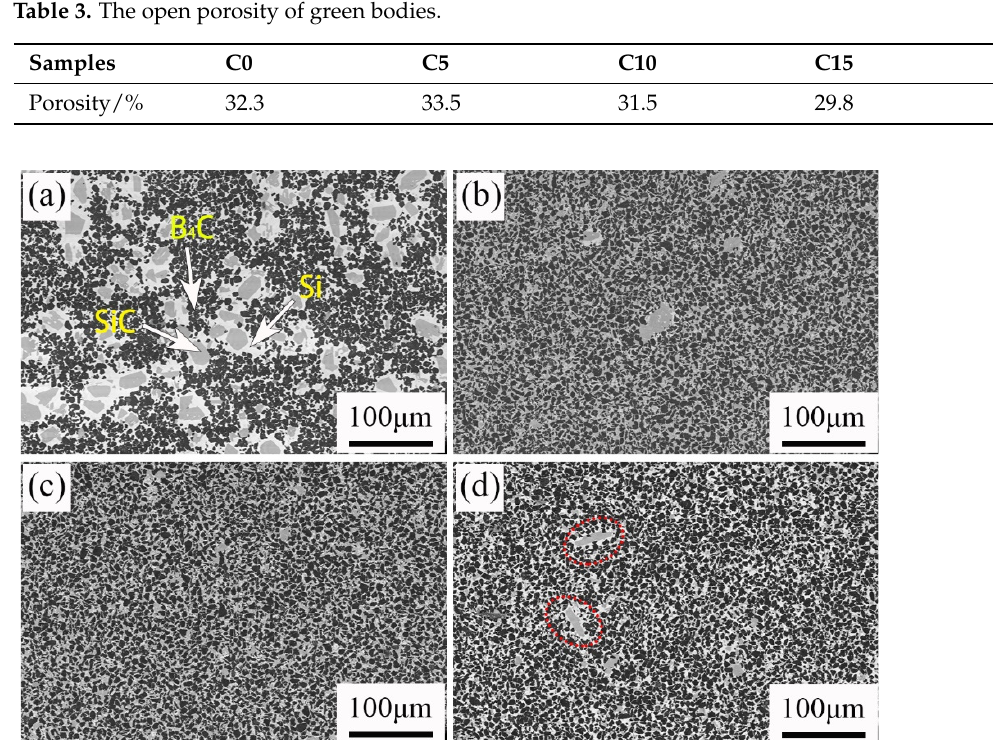
Figure 3. Backscattered SEM images of RBBC composites with different carbon contents. ( a ) 0; ( b ) 5 wt%; ( c ) 10 wt%; ( d ) 15 wt%. Table 2. The residual silicon content of composites.